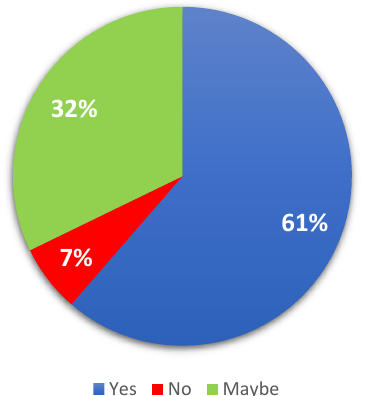
Figure 3. Drones’ utility for economic growth. Source: Author’s processing.